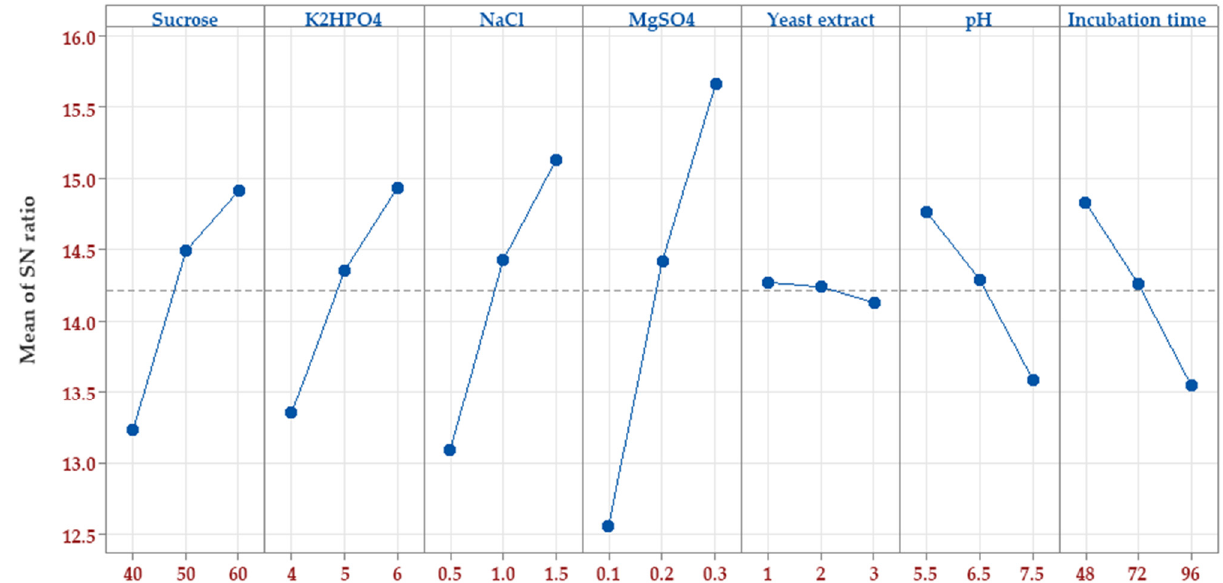
Figure 3. The plot of the S/N ratio effect based on larger-is-better for pullulan biosynthesis by A. pullulans .